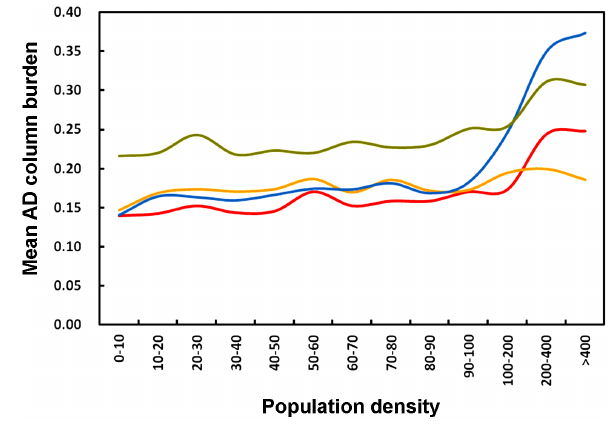
Figure 9. Mean anthropogenic dust (AD) column burden (gm − 2 ) changes as a function of population density (personskm − 2 ).